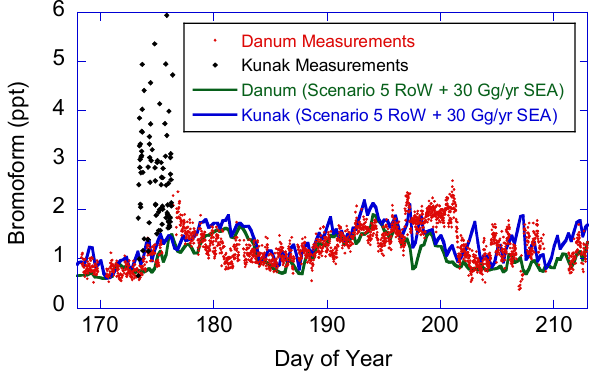
Fig. 8. Probability density functions (pdfs) for the NAME modelled concentrations at Danum (blue) and Kunak (red). 0.25ppt bins were used, and the number of model time-steps from which the pdfs are calculated (1081) is indicated. Mean modelled concentrations are indicated by the solid vertical lines.